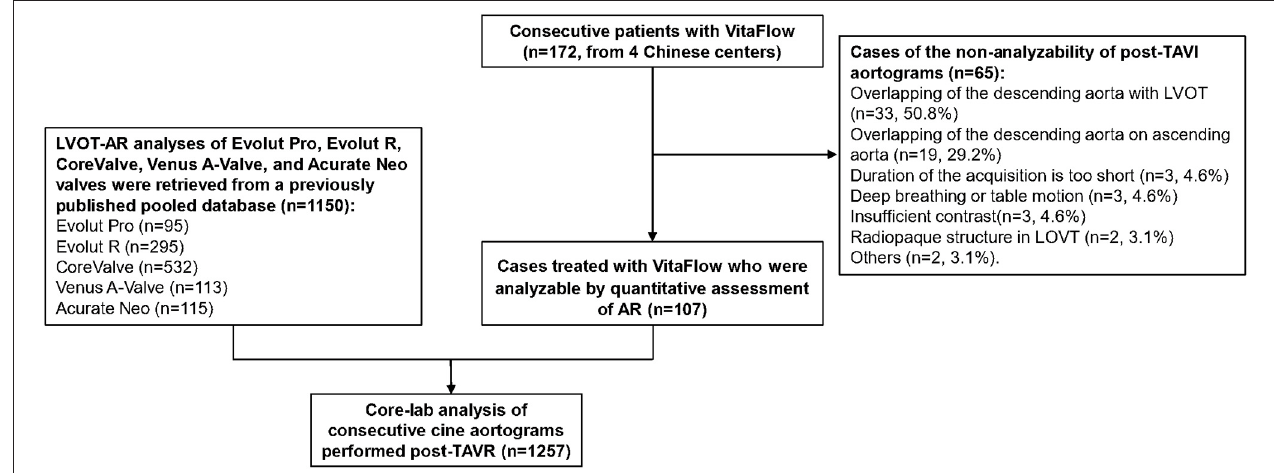
FIGURE 1 | The study flow chart.